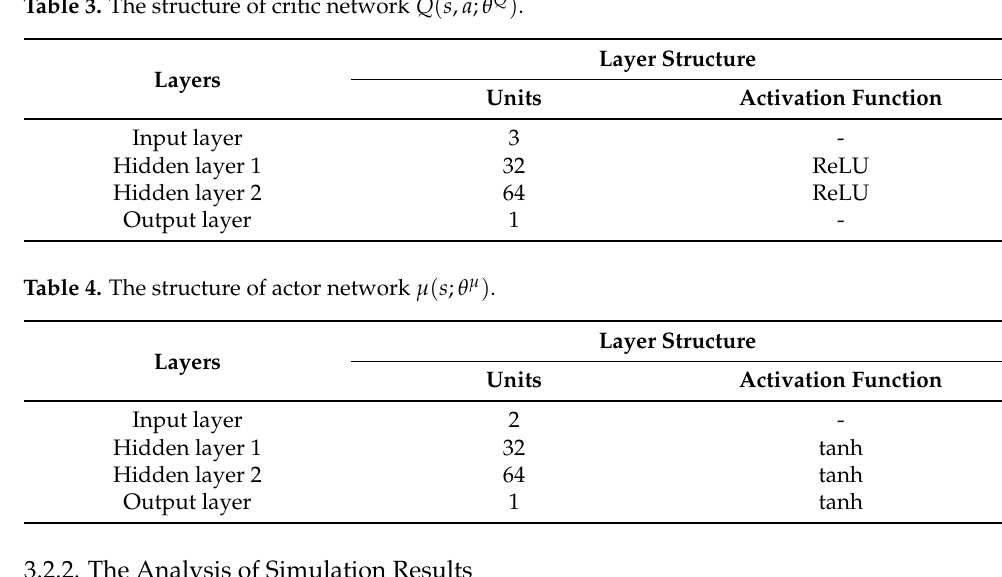
Table 3. The structure of critic network Q ( s , a ; θ Q ) .